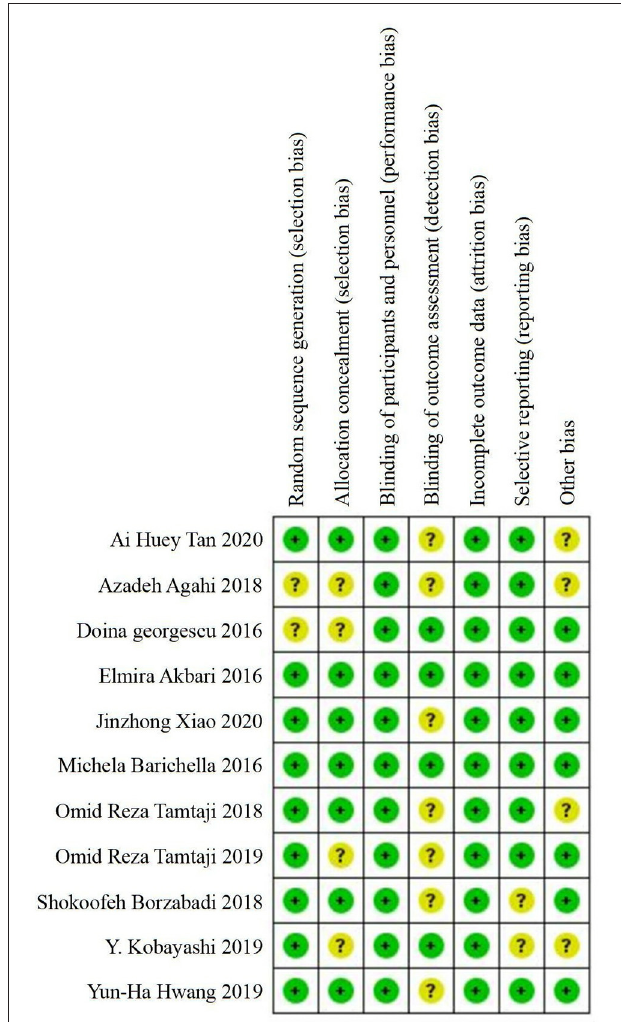
FIGURE 2 | Summary of risk of bias assessment: judgements of the review authors on each risk of bias item for the included studies ( n = 11).